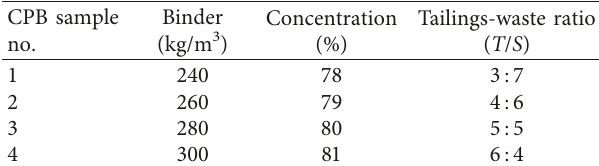
Table 3: Scheme of experiment L